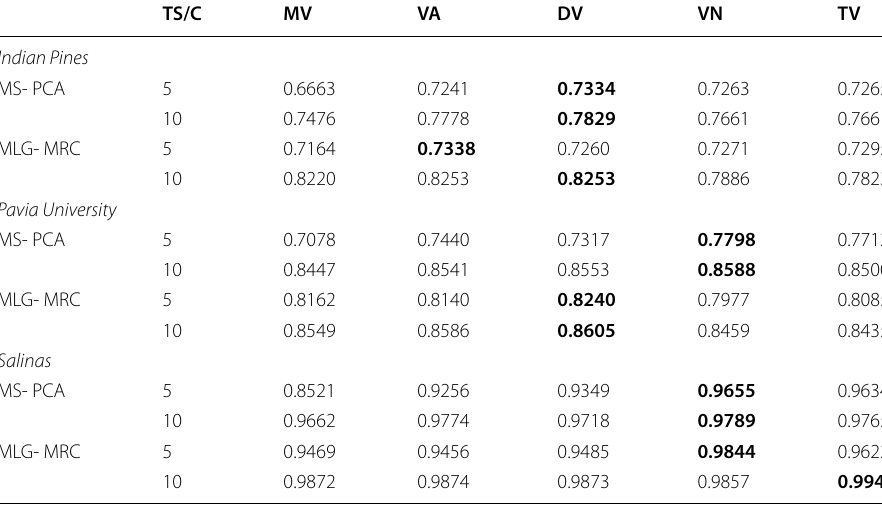
The best performances are marked in bold